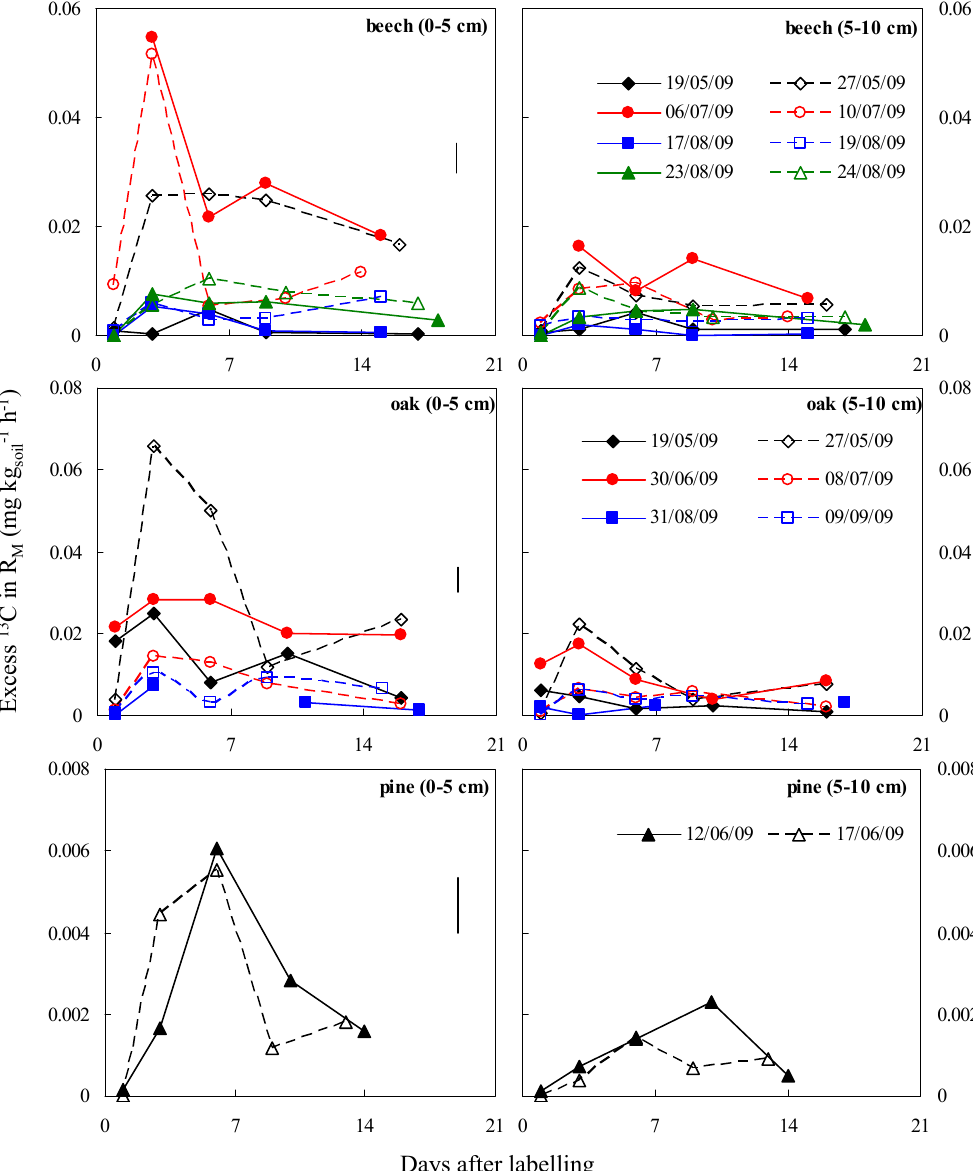
Fig. 3. Time courses of Excess 13 C in microbial respiration ( R M ) after whole crown pulse labelling of beeches (top), oaks (middle) and pines (bottom) at 0–5cm depth (left) and 5–10cm depth (right). Each tree is identified by its date of labelling. There are significant differences between trees for beech ( F 7 , 78 = 23 . 1, p < 0 . 001) and oak ( F 5 , 23 = 13 . 3, p < 0 . 001), between depths ( F 1 , 78 = 44 . 9, F 1 , 23 = 31 . 7 and F 1 , 20 = 15 . 8 for beech, oak and pine respectively, p < 0 . 001) and between sampling dates ( F 64 , 78 = 4 . 6, F 23 , 23 = 3 . 5 and F 16 , 20 = 3 . 2 for beech, oak and pine respectively, p < 0 . 001). The verticals bars represent the root mean error. Data are presented on two different panels according to depth but depth was included in the